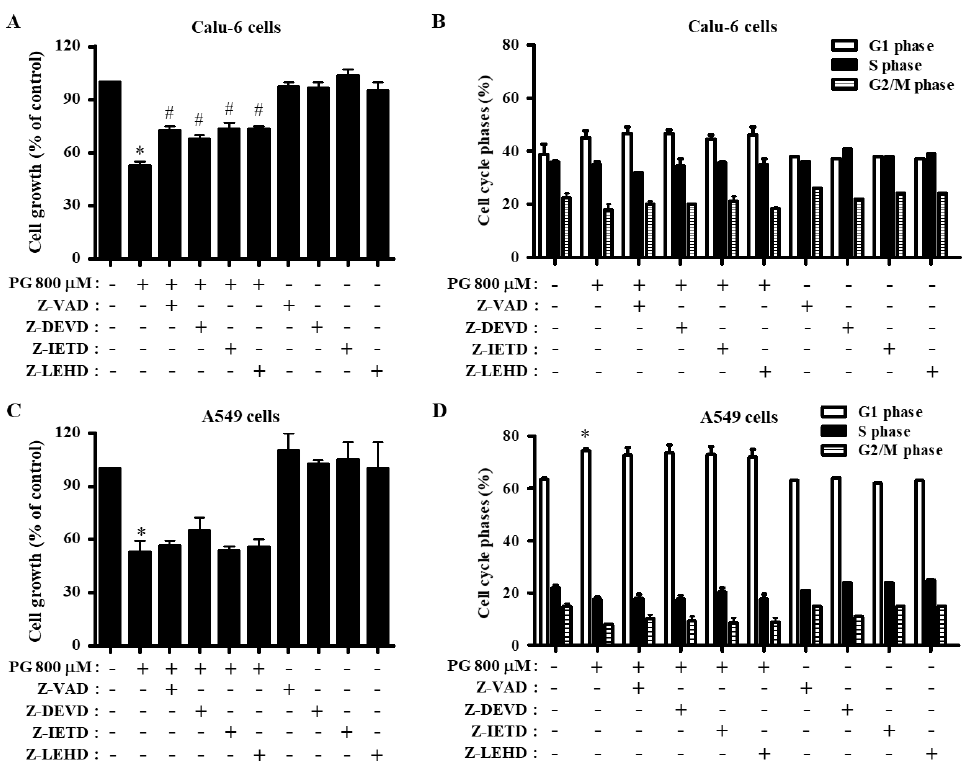
Figure 2. Effects of PG and caspase inhibitors on growth and cell cycle phase distributions in lung cancer cells. Exponentially growing cells were incubated with 800 µ M PG and/or each caspase inhibitor (15 µ M) for 24 h. Cell growth inhibition was evaluated by MTT assays. Cell cycle phase distributions were evaluated by DNA flow cytometry. ( A , B ) Graphs show cell growth ( A ) and cell cycle phase distributions in Calu-6 cells ( B ). ( C , D ) Graphs show cell growth ( C ) and cell cycle phase distributions in A549 cells ( D ). * p < 0.05 compared with the PG-untreated control group. # p < 0.05 compared with cells treated with PG only.